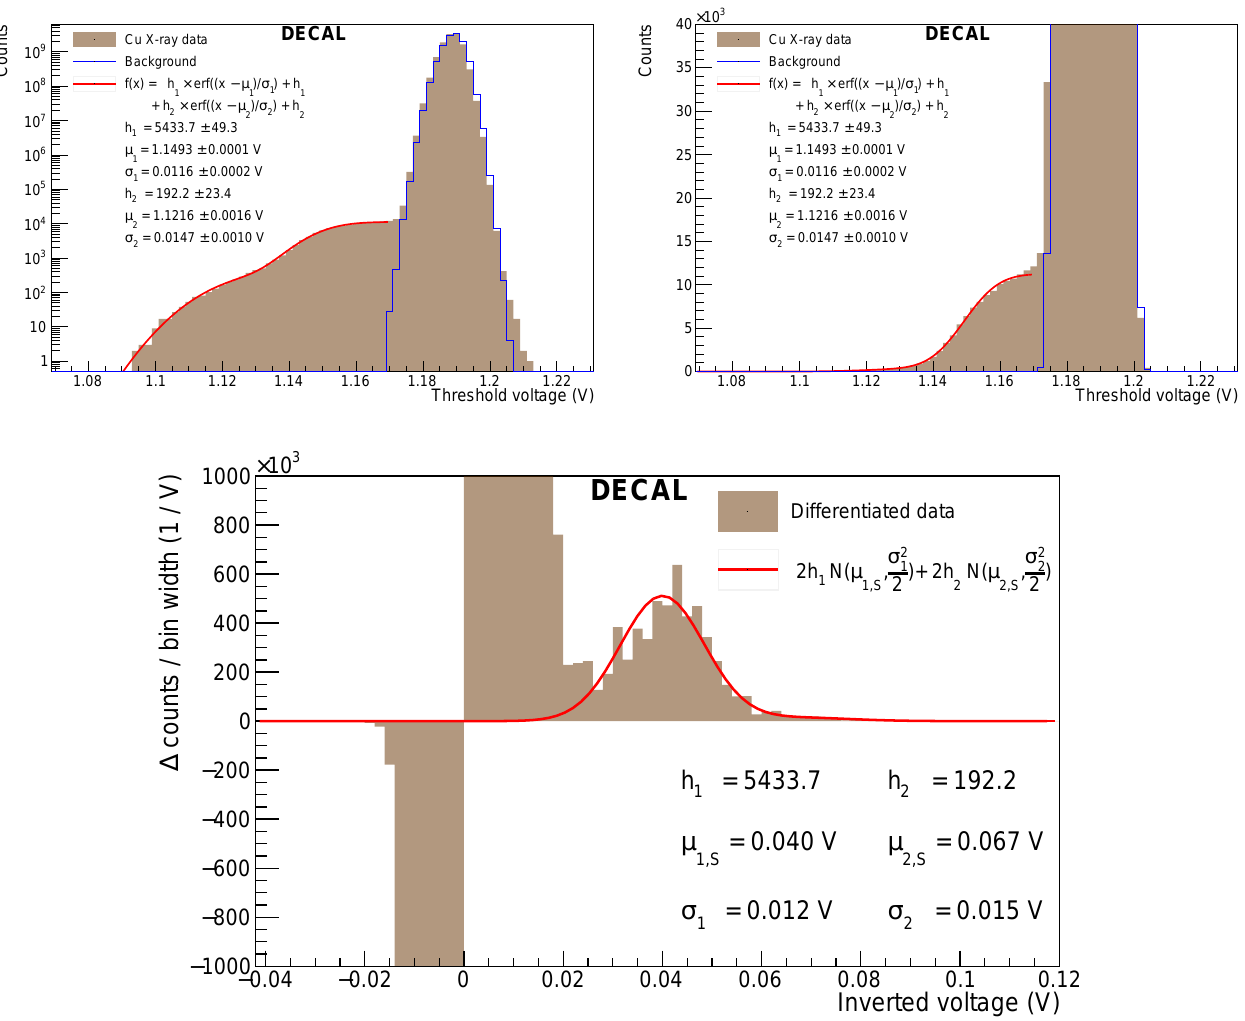
Figure 19. Threshold scan with the DECAL chip under Cu X-ray fluorescence on logarithmic ( top left ) and linear scale ( top right). The bottom plot shows the binwise differentiated data on an inverted x-axis whose origin is defined to be the baseline voltage. The numerical differentiation is the difference in counts between neighbouring threshold scan bins divided by their width of 2 mV. The fit function is analytically differentiated and two Gaussians are obtained. Background data measured when the X-ray source is turned off are indicated by the blue